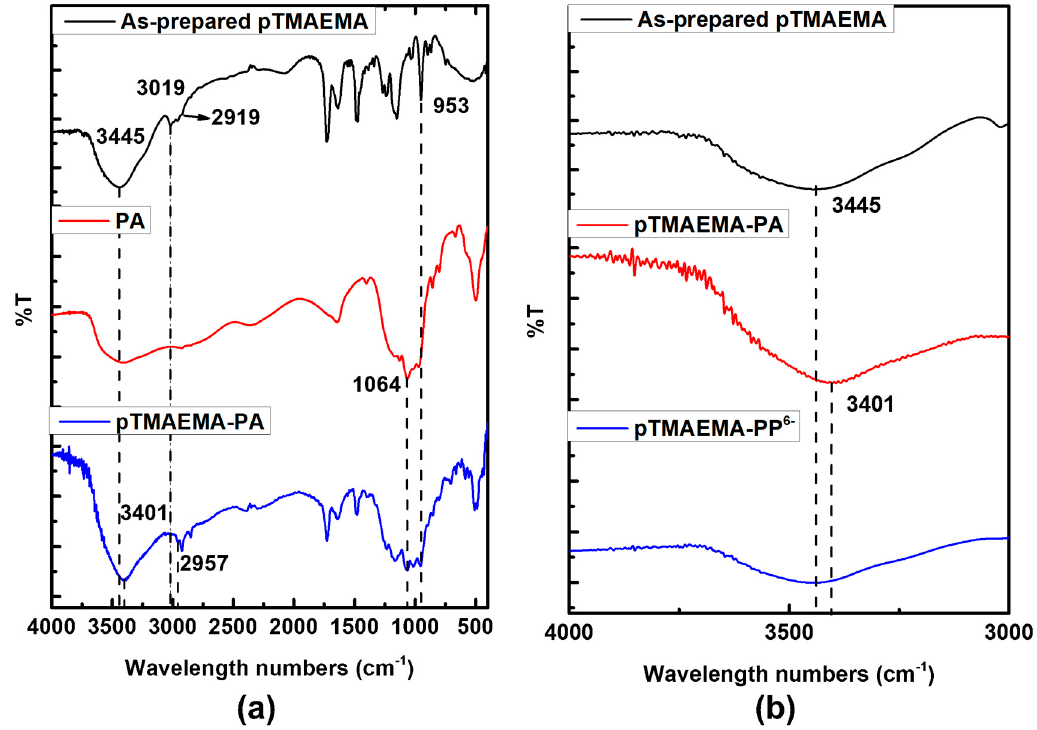
Figure 7. FTIR spectra analysis: ( a ) Comparison of FTIR spectra between as-prepared pTMAEMA, PA and pTMAEMA-PA. ( b ) Comparison of FTIR spectra between as-prepared pTMAEMA, pTMAEMA-PA and pTMAEMA-PP 6 − at the region from 3000 to 4000 cm − 1 .